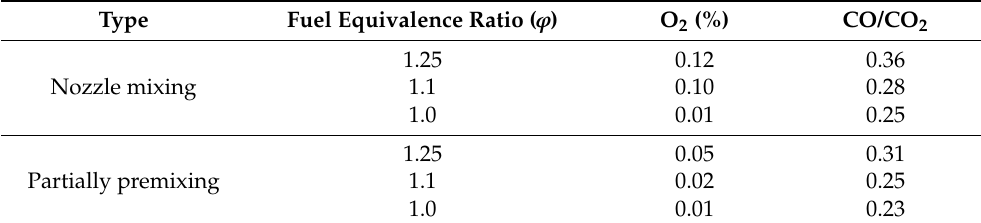
Table 3. Comparison of O 2 concentration (%) and CO/CO 2